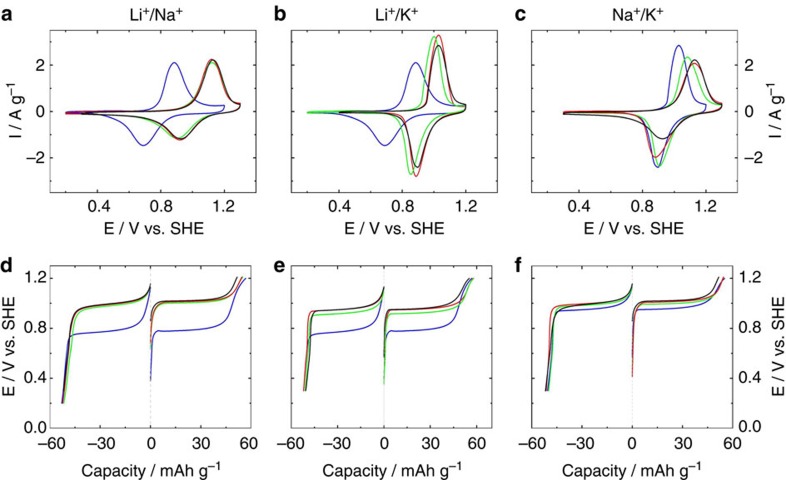
Electrochemical properties of InHCF/Gr.(a–f) Cyclic voltammograms (a–c) at a
scan rate of 2 mV s−1 and galvanostatic
profiles (d–f) measured at a rate of 1C for InHCF/Gr in
various electrolytes
(1C=60 mA g−1). All electrode
potentials are versus standard hydrogen electrode (SHE). Blue line is
corresponding to 0.5 M Li2SO4 in
a,b,d and e) or 0.5 M
K2SO4 in c and f Green line is
corresponding to 0.25 M Li2SO4/0.25 M
Na2SO4 in a and d or 0.25 M
Li2SO4/0.25 M K2SO4
in b and e or 0.25 M
Na2SO4/0.25 M K2SO4 in
c and f. Red line is corresponding to 0.1 M
Li2SO4/0.4 M Na2SO4
in a and d or 0.1 M Li2SO4
/0.4 M K2SO4 in b and e or
0.4 M Na2SO4/0.1 M
K2SO4 in c and f. Black line is
corresponding to 0.5 M Na2SO4 in
a,c,d and f or 0.5 M
K2SO4 in b and e.